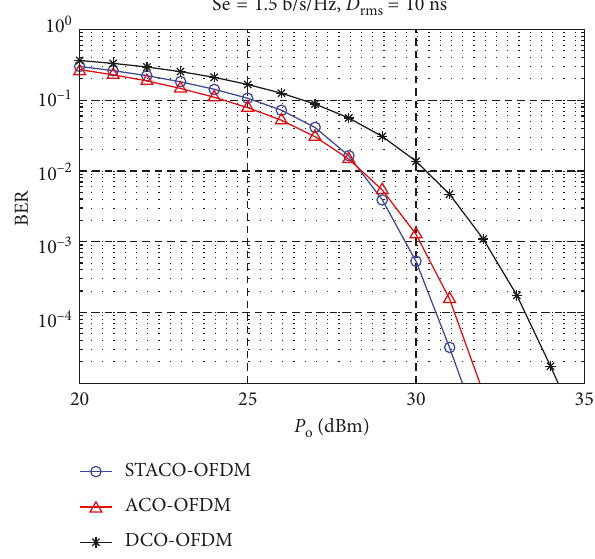
Figure 12: BER versus optical power performance of STACO- OFDM, ACO-OFDM, and DCO-OFDM with spectral efficiency of 1.5bits/s/Hz over multipath channel with D rms